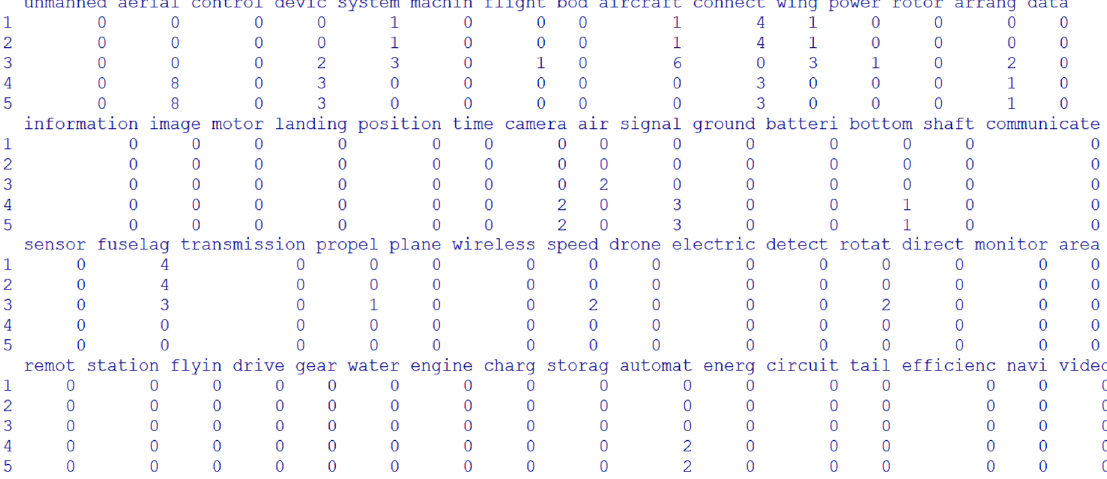
Figure 3. Part of the document-word matrix data of drone patent documents.